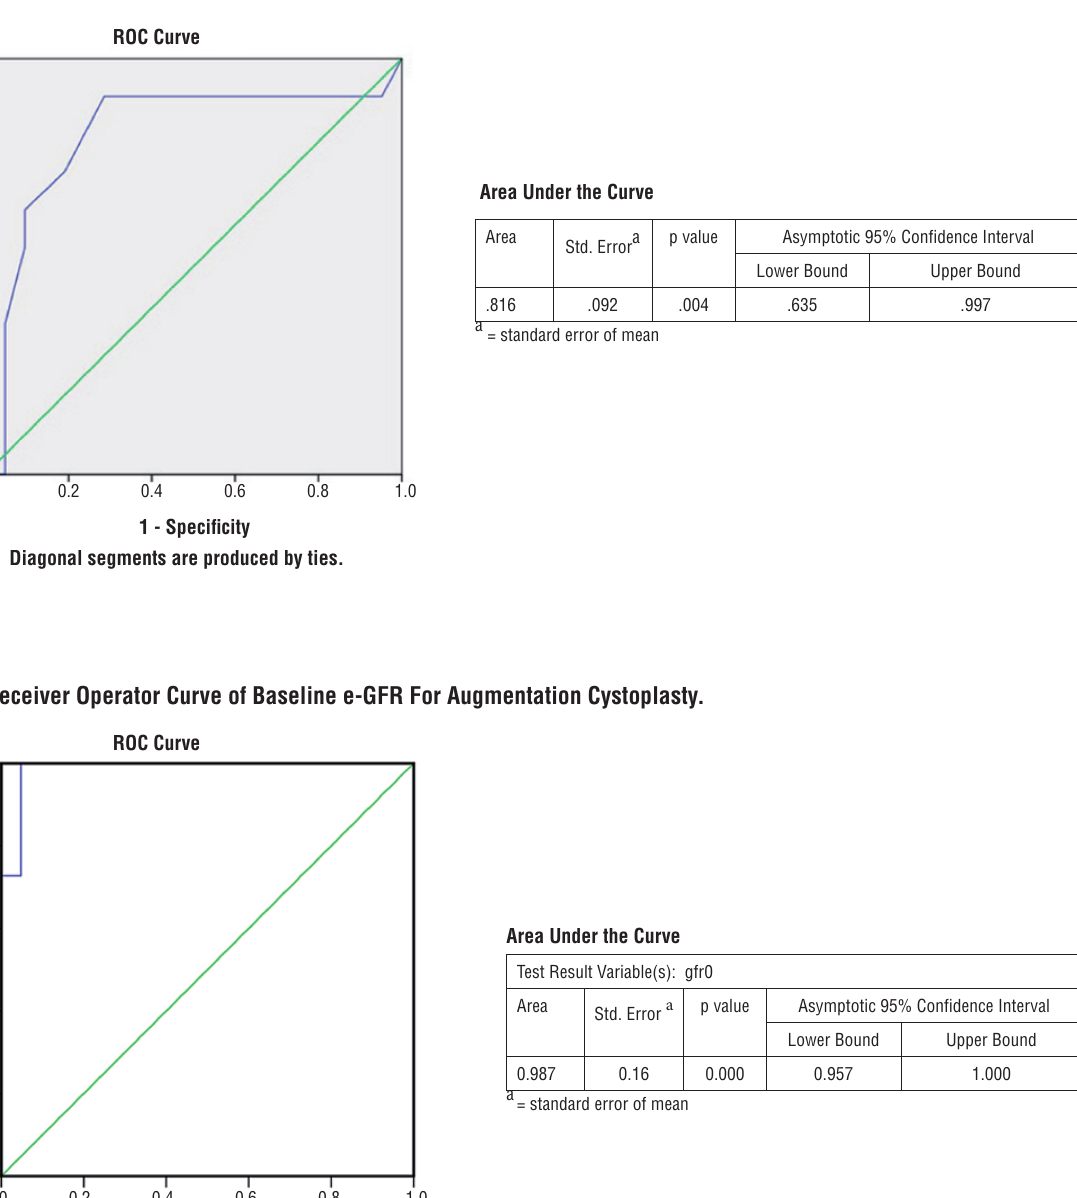
Figure 1 - Receiver Operator Curve of Baseline serum Creatinine for Augmentation Cystoplasty.